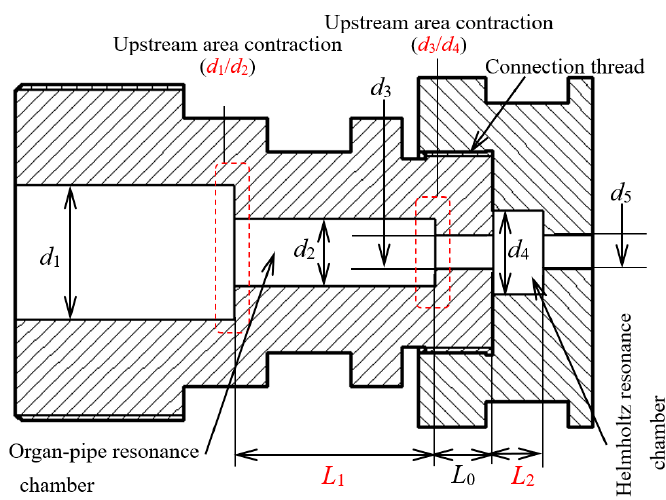
Figure 3. The structure diagram of organ–Helmholtz (OH) self-excited oscillation nozzle.